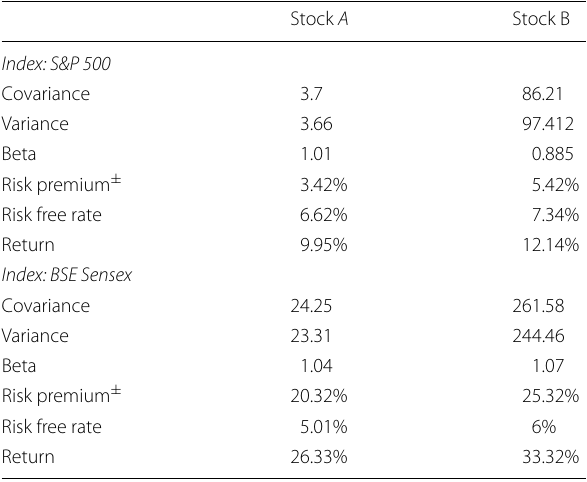
represents only the equity risk premium and does not include the country risk ± premium (e.g., reinvestment risk and default or credit